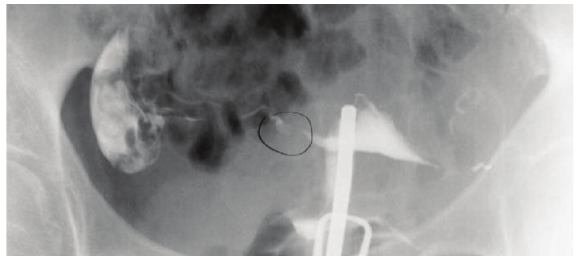
Figure 1: Hysterosalpingography. Circle indicates large right-sided tubal cornual polyp. Note tubal patency.